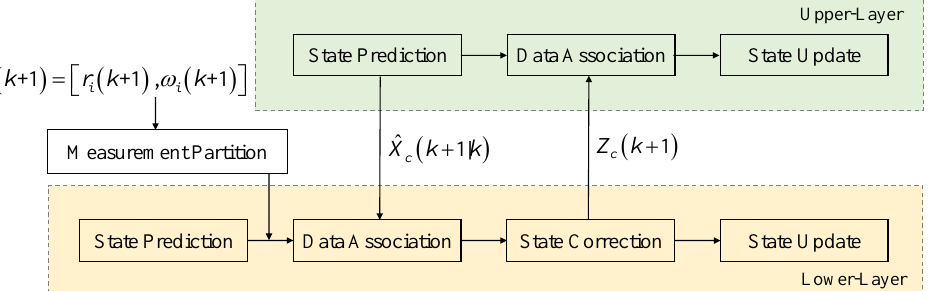
Figure 2. The framework of the layered